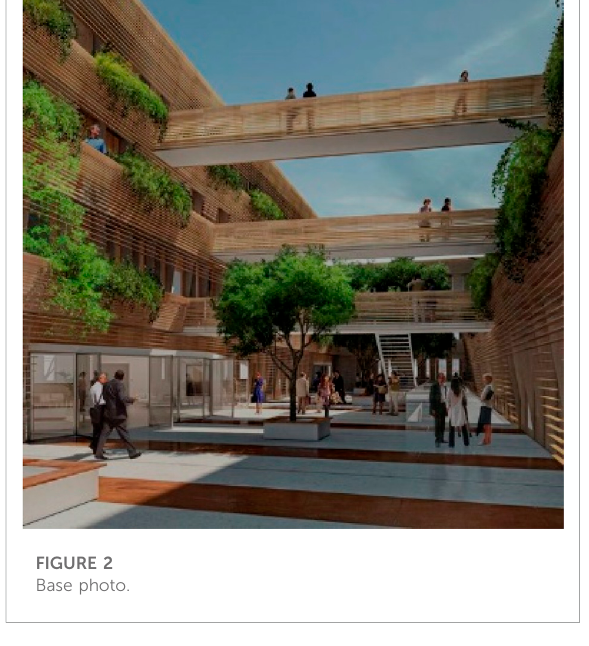
FIGURE 2 Base photo.